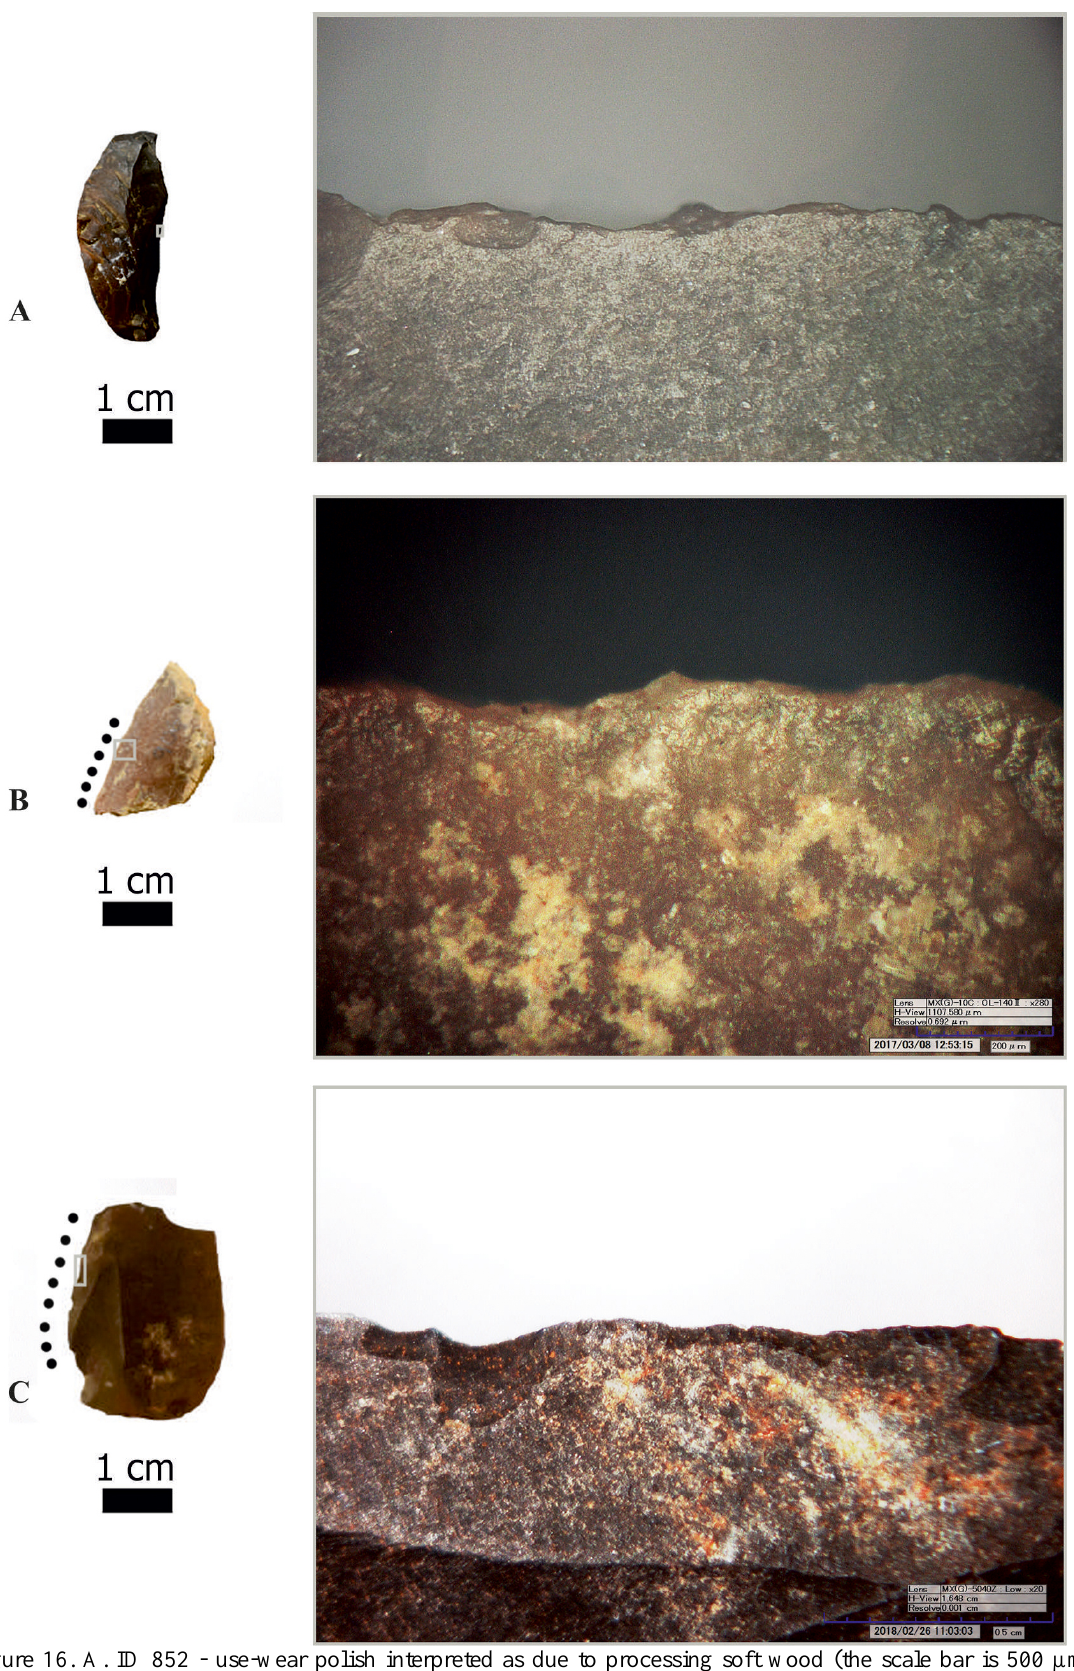
Figure 16. A. ID 852 - use-wear polish interpreted as due to processing soft wood (the scale bar is 500 µm); B. ID 906 - edge rounding associated with use-wear polish from cutting dry skin (the scale bar is 200 µm); C. ID 531 - edge scarring related to cutting hard material (the scale bar is 0.5 cm